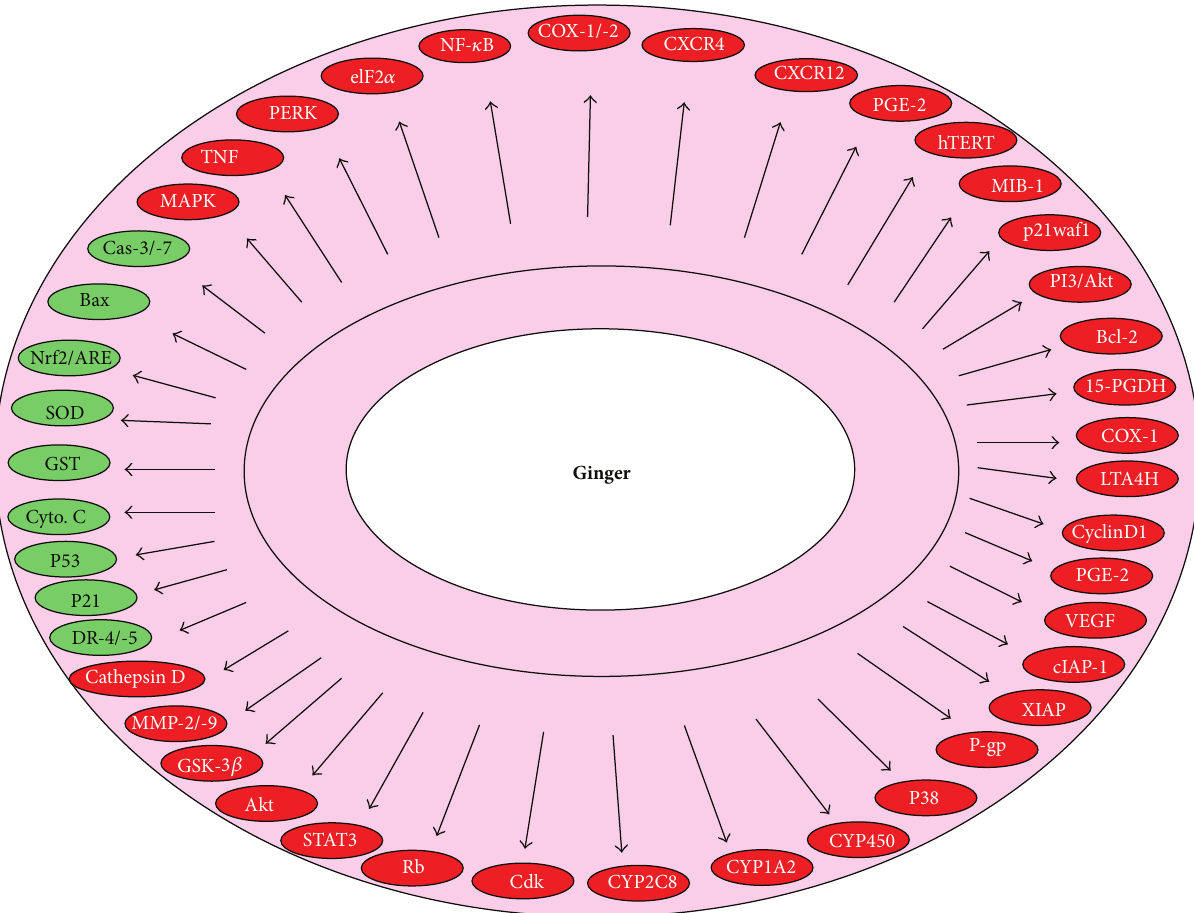
Figure 3: Molecular targets of ginger and its active constituents against gastrointestinal